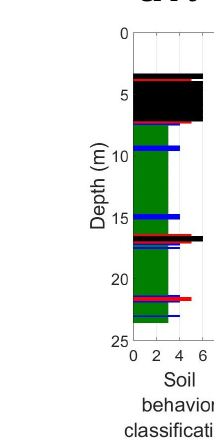
Figure 4. Soil behaviour classification with depth based on the cone penetration test.